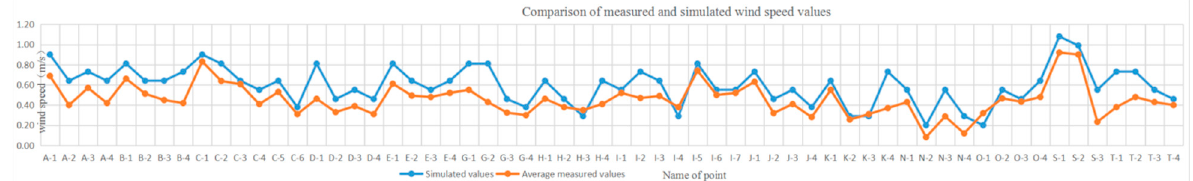
Figure 5. Comparison of the measured and simulated wind speed values of 60 points in Prince Kung’s Mansion (Fengshui layout, the point names are from Figure 1c). Kung’s Mansion (Fengshui layout, the point names are from Figure 1c). There was a linear regression between the measured values and the simulated values.